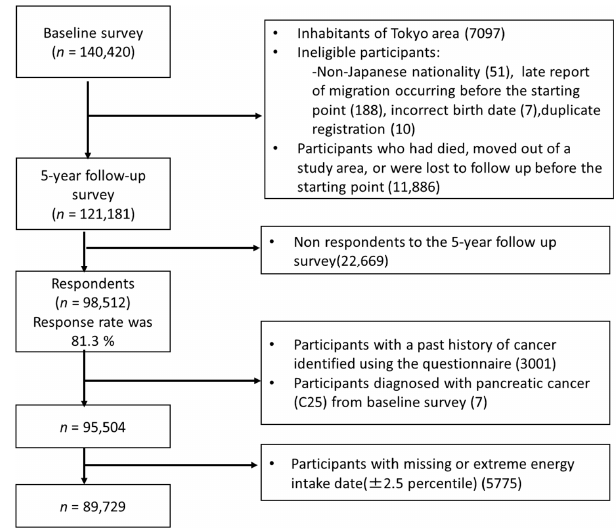
Figure 1. Flow diagram of the study participant selection.